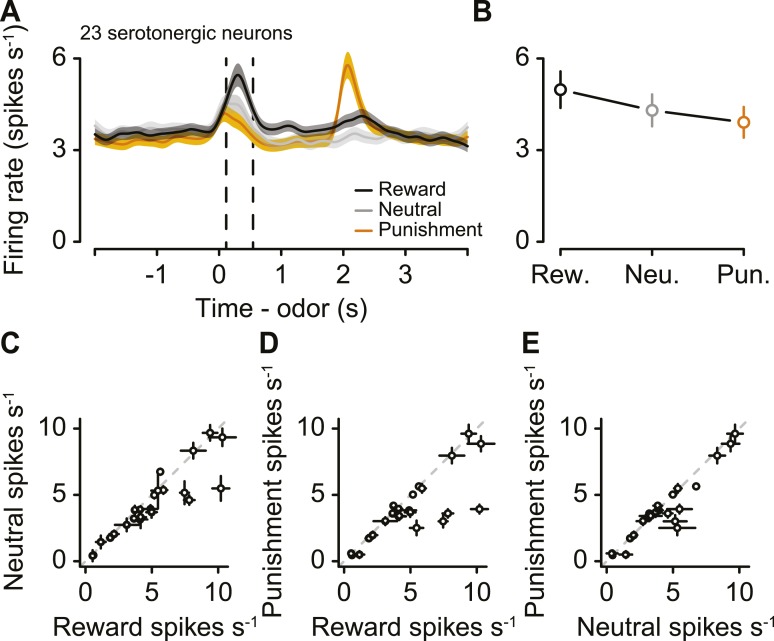
Serotonergic neurons signal value, not salience, in response to the CS.(A) Mean ± S.E.M. firing rate of serotonergic neurons during all three trial conditions. (B) Mean ± S.E.M. firing rate during the CS epoch (region bounded by dashed lines in A) for each trial condition. (C–E) Mean ±95% confidence intervals around firing rates during the CS epoch for neutral vs reward (C), punishment vs reward (D), and punishment vs neutral (E).